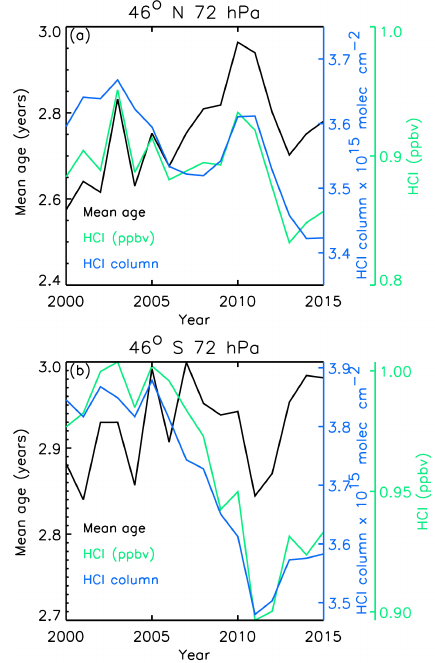
Figure 3. The evolution of the GMI CTM HCl mixing ratio (green) and mean age (black) at 72hPa and the HCl column (blue) at (a) 46 ◦ N and (b) 46 ◦ S. The HCl column is N × 10 15 molecules per cm 2 , where N is the right blue axis. The time interval begins in 2000 when the chlorine-containing source gases have stopped in- creasing or begun to